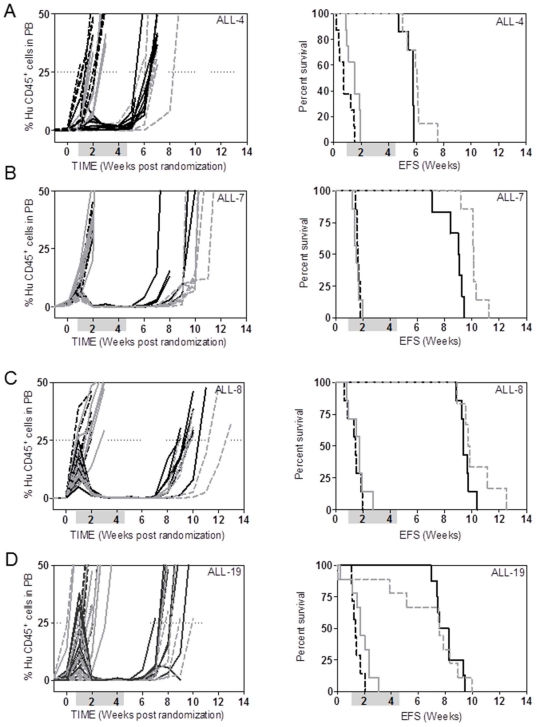

In vivo sensitivity of ALL xenografts to VXL and VXL/ATO combination treatments.Female mice were engrafted with: ALL-4 (A); ALL-7 (B); ALL-8 (C); or ALL-19 (D) and treated with a diluent vehicle (controls, dashed black lines), ATO (2.5 mg/kg, solid grey lines), VXL combination (solid black lines), or VXL+ATO quadruple combination (dashed grey lines). Engraftment kinetics indicated by %huCD45+ cells in PB of individual mice (left panel) and Kaplan-Meier survival curves (EFS) (right panel) are shown. Shaded boxes represent the treatment period.